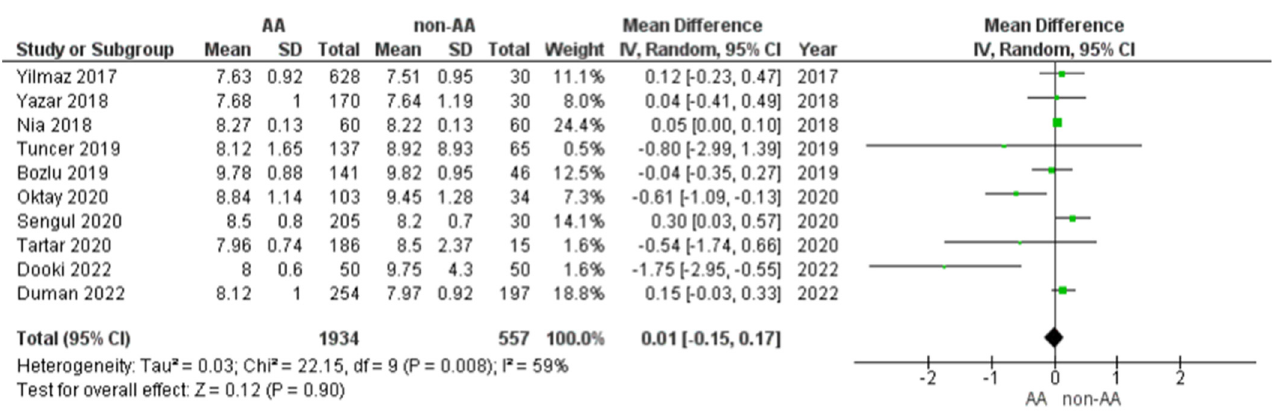
Figure 3. Forest plot comparison between the two patient groups (AA versus non-AA) in terms of the average values of mean platelet volume. Abbreviations: AA, acute appendicitis; non-AA, non- acute appendicitis; IV, inverse variance; CI, confidence interval.